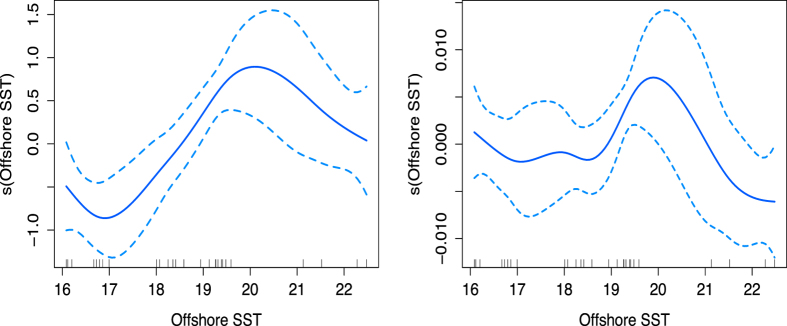
Generalised additive model relationships between log transformed prey capture by penguins per 90 min and offshore SST (left); and catch per unit effort (number of prey caught by penguins/amount of time spent diving > 1.5m) & offshore SST (right).